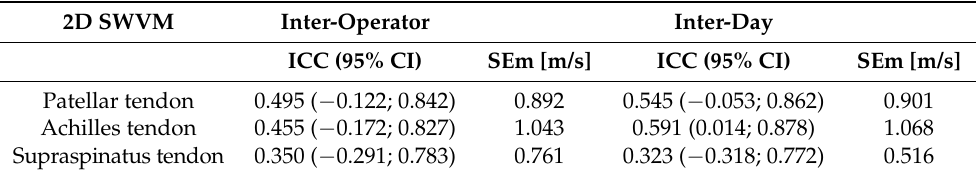
Table 3. Estimates of intra-class correlation coefficients (ICC) and standard error of measurement (SEm) for the assessment of the patellar, Achilles, and supraspinatus tendons using 2D shear wave velocity